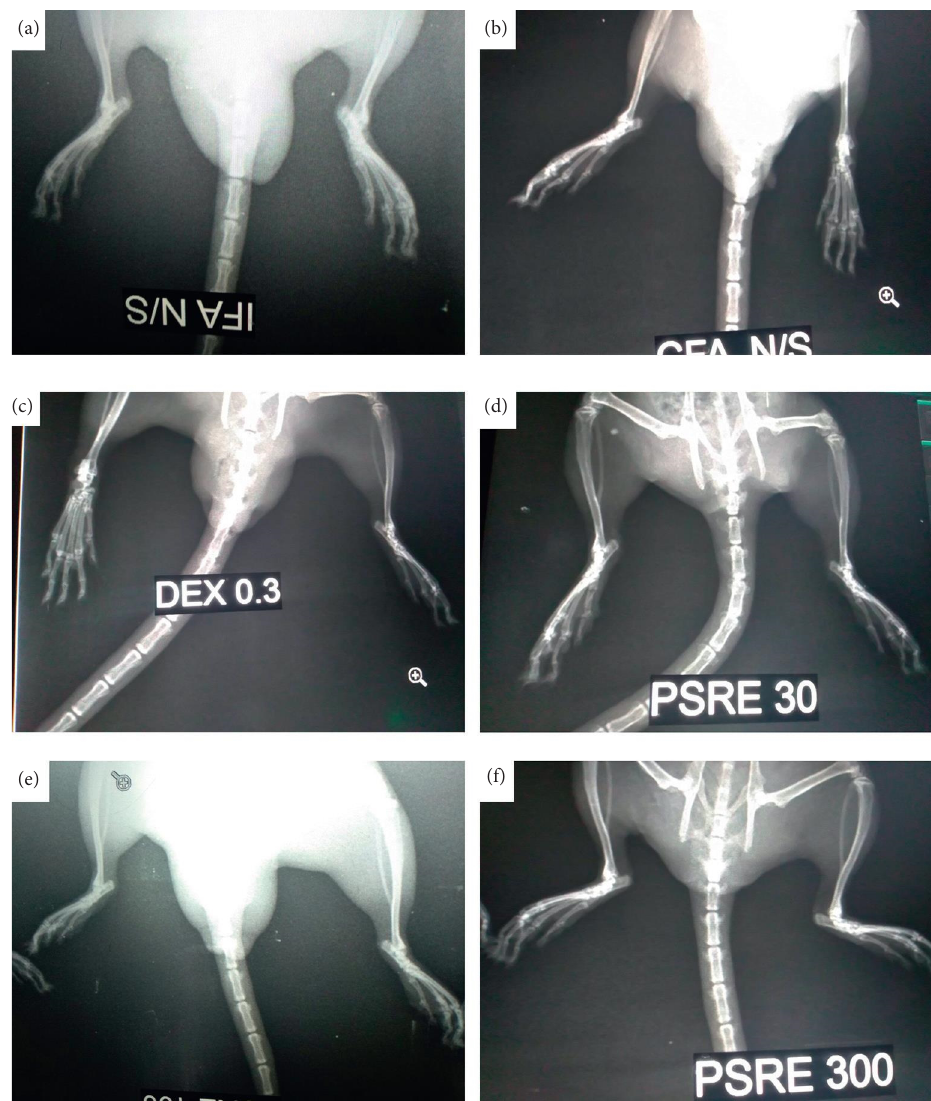
Figure 3: Radiographs of rats pretreated with IFA (a), CFA (b), dexamethasone (c), 30mgkg − 1 of PSRE (d), 100mgkg − 1 of PSRE (e) and 300mg kg − 1 of PSRE (f) in adjuvant-induced